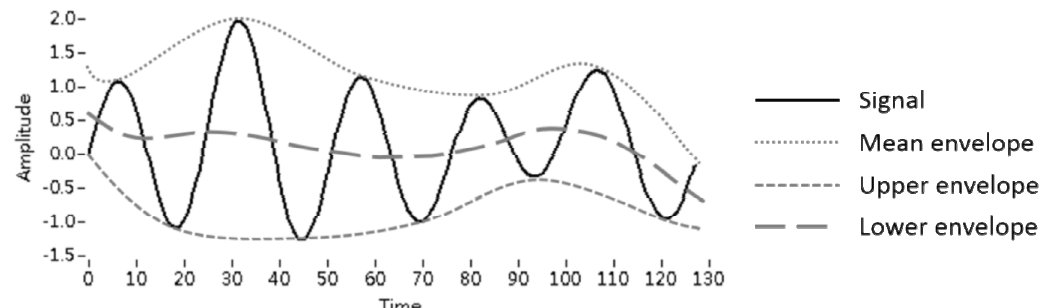
Figure 6. An example of